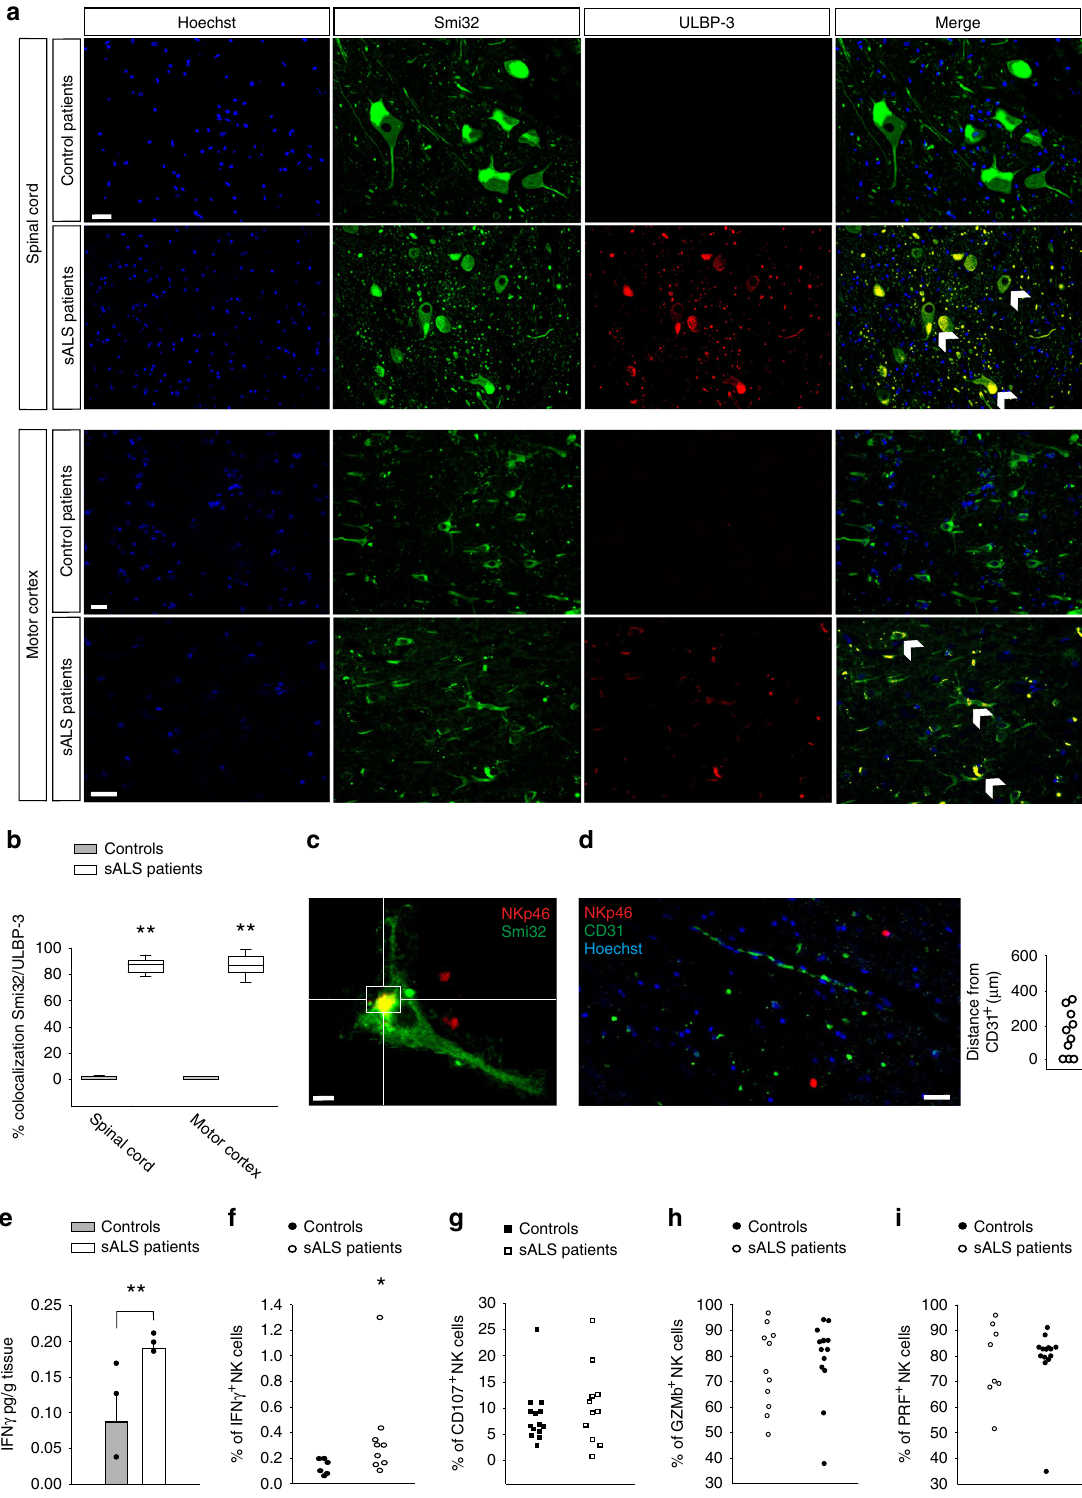
Image acquisition and data analysis . Images were digitized using a CoolSNAP camera (Photometrics) coupled to an ECLIPSE Ti-S microscope (Nikon) and processed using MetaMorph 7.6.5.0 image analysis software (Molecular Device). Slices were scanned by consecutive fi elds of vision (×10 objective lens) to build a single image per section. Data were expressed as area occupied by fl uorescent cells versus total area by converting pixel to mm. For comparison between different treatments, at least 12 coronal sections per lumbar spinal cord or brain were